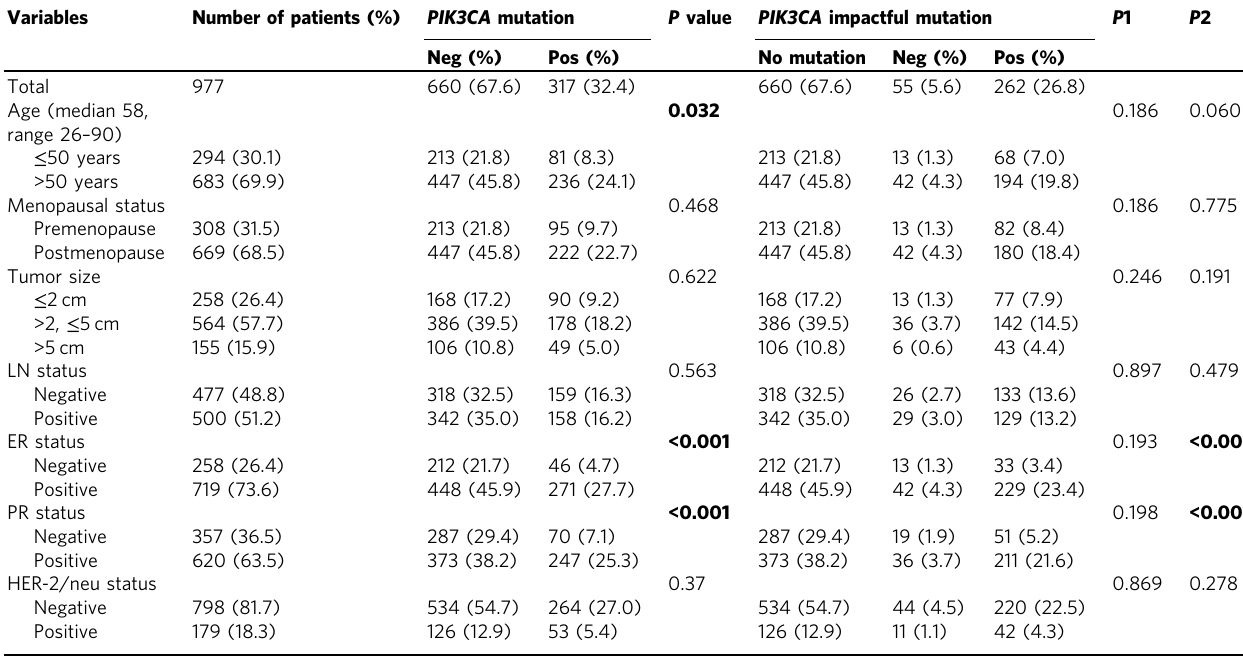
Table 1 Clinicopathological variables and PI3KCA mutations in TCGA database Variables Number of patients